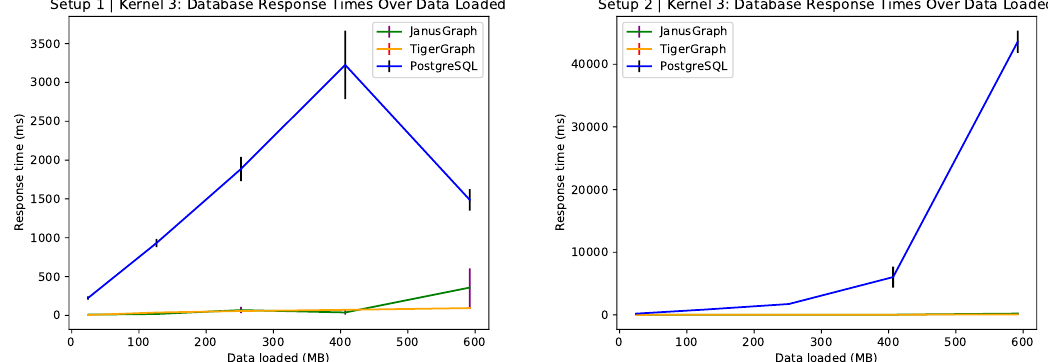
Figure 8. Database response times over varying percentages of the dataset for setup 1 and 2 for the kernel: “Ranking Las Vegas by Friends’ Sentiment”. The error bars display standard deviation.